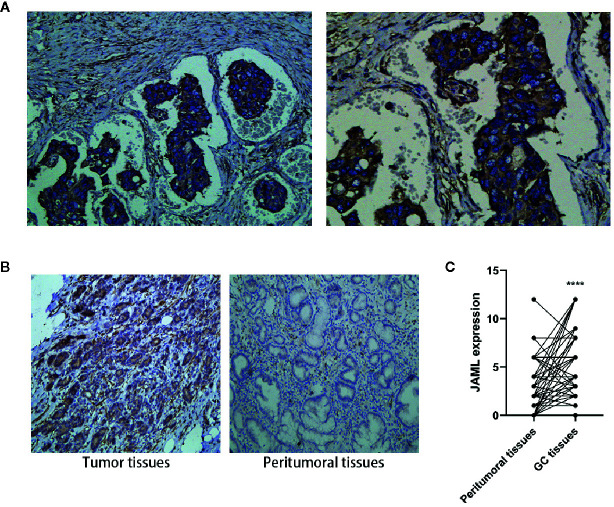
Expression of JAML in human gastric cancer (GC) and peritumoral tissues. (A) JAML expression on cytoplasm and membrane of GC cells. (B) The JAML expression in GC and peritumoral tissues. (C) Quantitative analysis of JAML expression in GC and peritumoral tissues. n=63, paired t test, ****P < 0.0001, compared with peritumoral tissues.